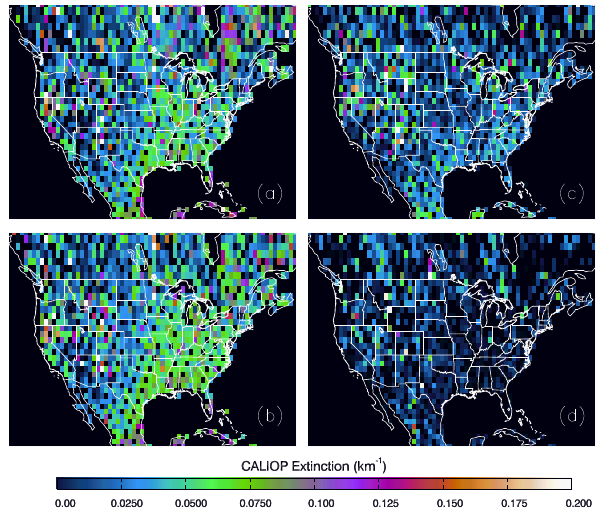
Figure 6. Two-year (2008–2009) 1 ◦ × 1 ◦ average CALIOP 0.532µm extinction, relative to the number of cloud-free 5km CALIOP profiles in each 1 ◦ × 1 ◦ bin, for atmospheric layers a.g.l. of (a) 0–500m, (b) 500–1500m, (c) 1500–2500m, and (d) 2500–